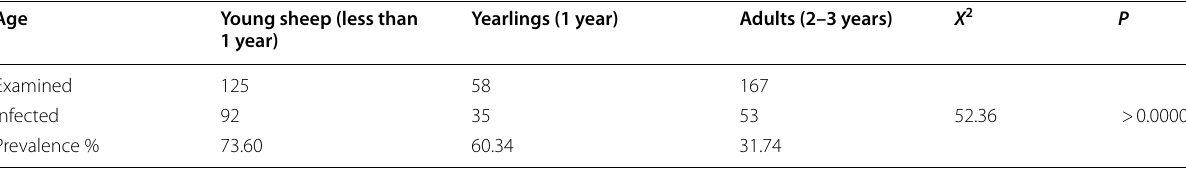
P value is considered significant at > 0.05